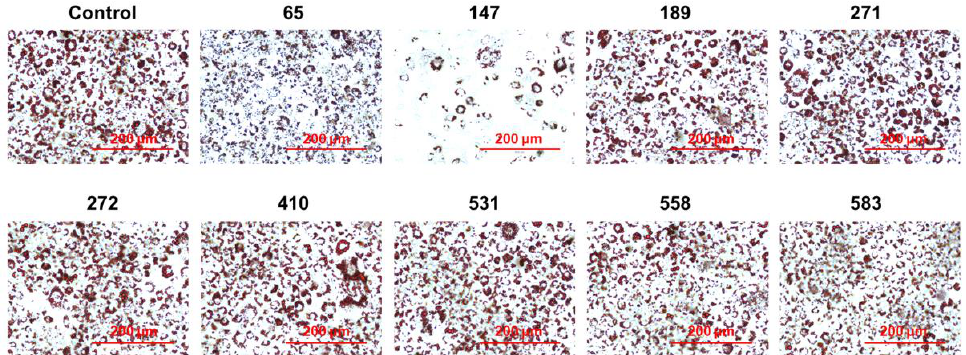
Figure 2. Anti-adipogenic activities of the nine selected compounds. After sorting out 45 hits by enzymatic assays, nine compounds were selected as novel compounds for the investigation of their anti-adipogenic activity. To validate the anti-adipogenic effects of the nine compounds, the cells were cultured until reaching 100% confluency. Then, the cells were treated with DMI containing 20 µ L of indicated compound or 0.1% DMSO as control. After 6 days of differentiation, the cells were fixed with 4% paraformaldehyde. Then, the fixed cells were stained by oil red O solutions and washed with distilled water. The stained cells were captured by a Cytation 7 cell imaging multimode reader; 65: alpha-boswellic acid; 147: chebulinic acid; 189: cyanidin chloride; 271: gallic acid ethyl ester; 272: gallocatechin gallate; 410: medicagenic acid; 531: quercetin 7-rhamnoside; 558: salvianolic acid c; 583: sennoside B. Scale bar: 200 µ